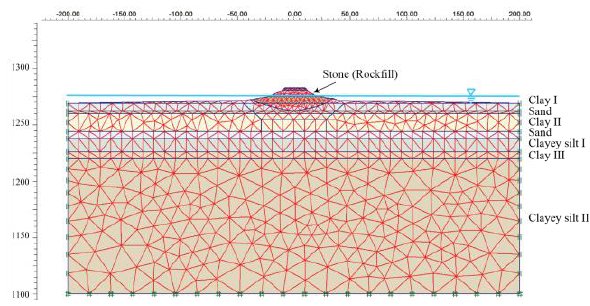
Figure 6. Geometry, finite element meshes, boundary conditions and soil types of the cross section at 4